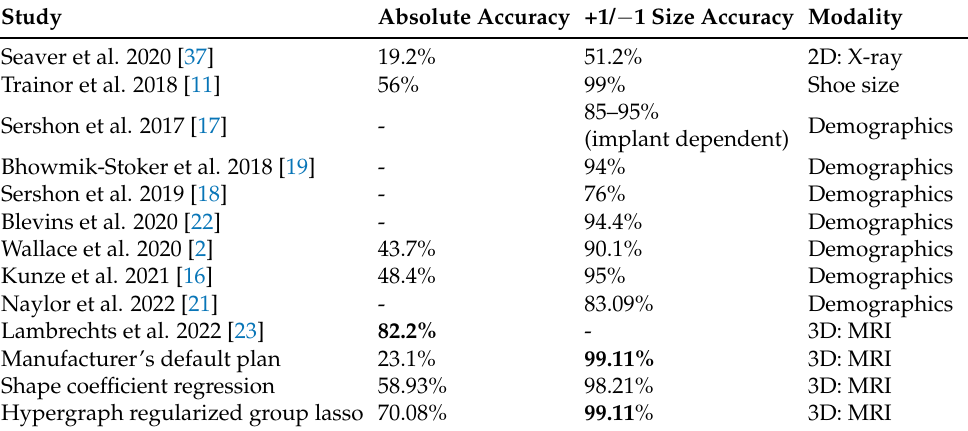
Table 3. Comparison of automatic methods for predicting femoral implant size in terms of their accu- racy. Bold values indicate the best performance per